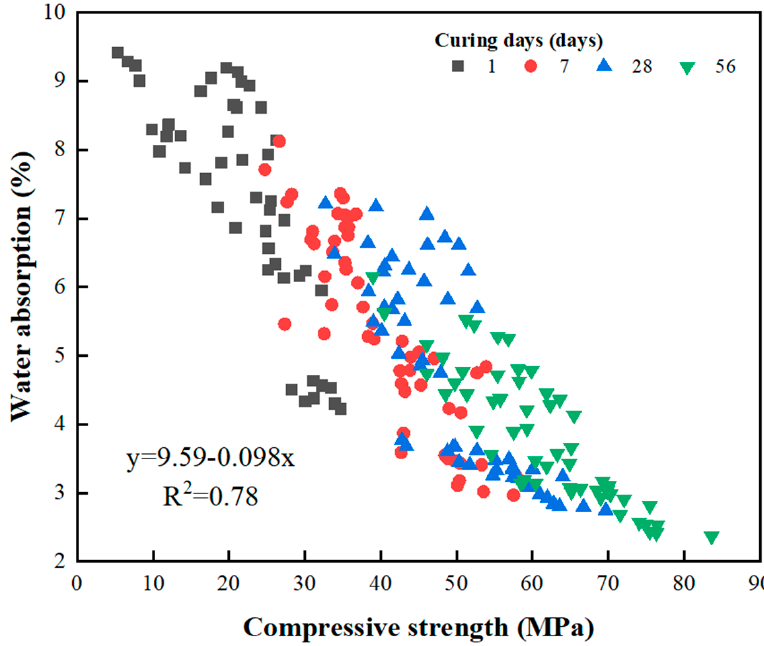
Figure 10. Linear regression analysis with compressive strength and water absorption of green and ecofriendly grouting material.